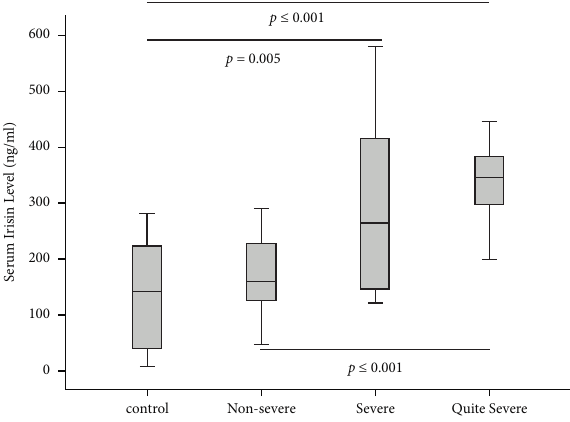
Figure 1: Serum irisin level in control group and the three OSA groups. Table 2: Correlation analysis between different parameters in the OSA